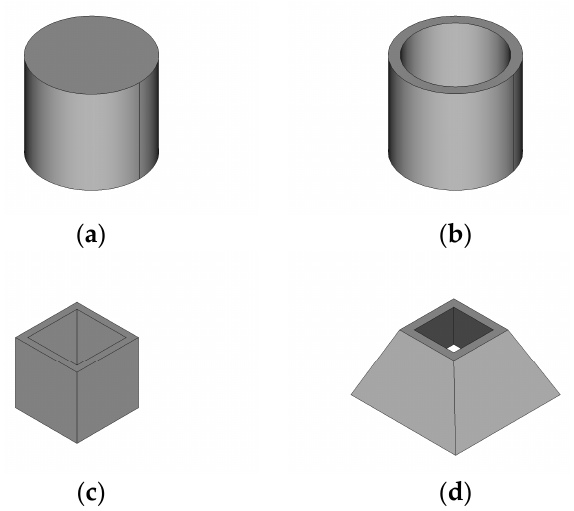
Figure 6. Dampers prototypes (own research; distinct geometry): ( a ) cylinder C100 and C50; ( b ) cylinder C00; ( c ) cube KP and KD; ( d ) pyramid PP, PD.